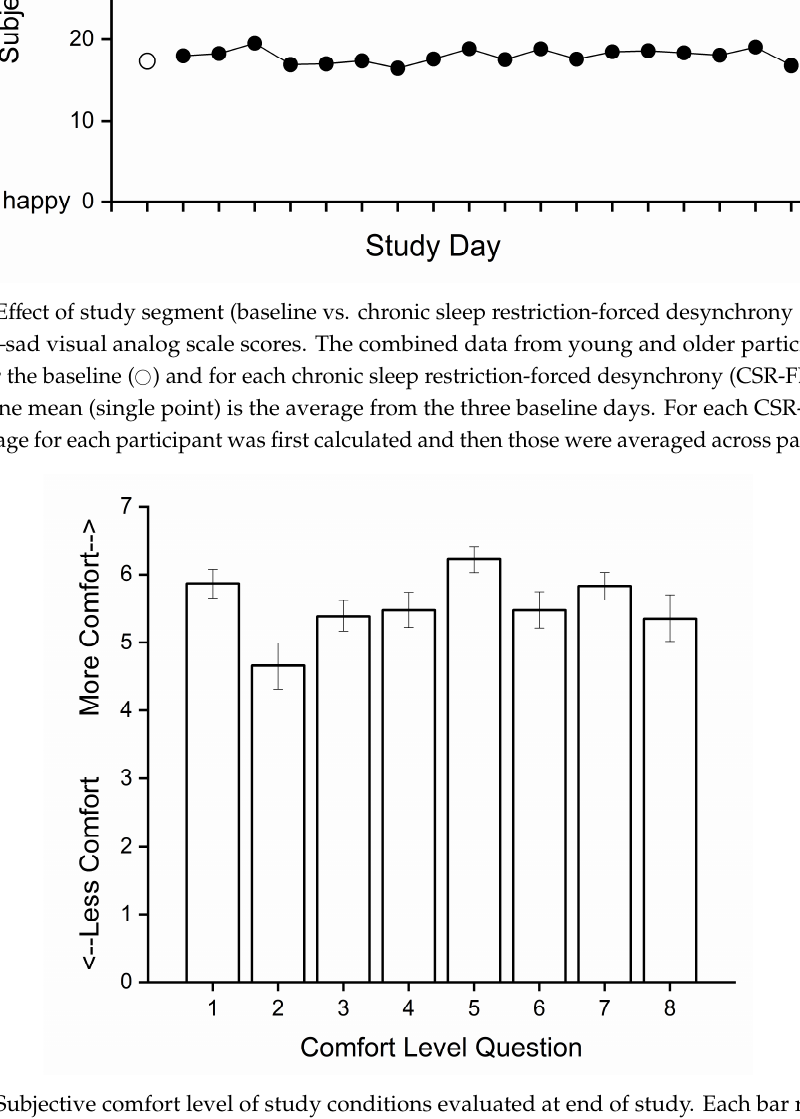
Figure 3. Subjective comfort level of study conditions evaluated at end of study. Each bar represents the mean and standard error of evaluations on one comfort level question from 23 of the 24 participants. Responses were rated on a 1 to 7 scale where 1 was “extremely bad” comfort level and 7 was “extremely good” comfort level. The comfort level categories shown on the x-axis are: 1: IV catheter, 2: core temperature sensor, 3: scalp electrodes, 4: face electrodes, 5: wrist activity monitor, 6: test frequency, 7: test duration, and 8: constant Posture condition.